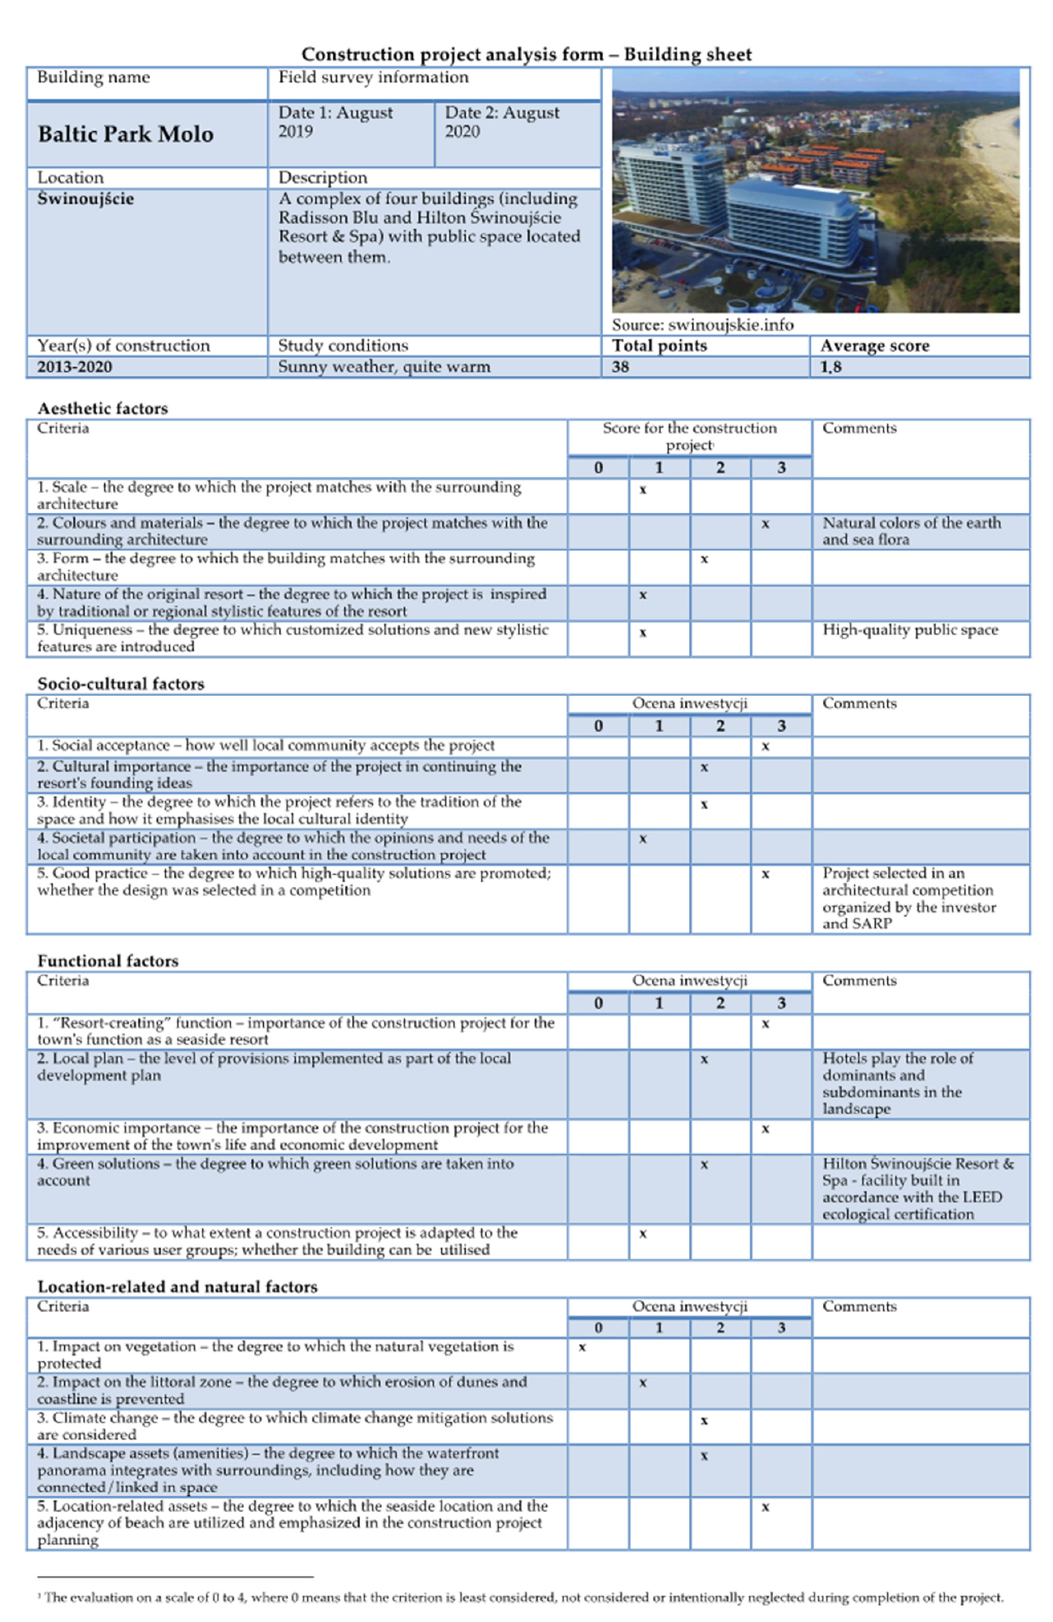
´Swinouj´scie. Building